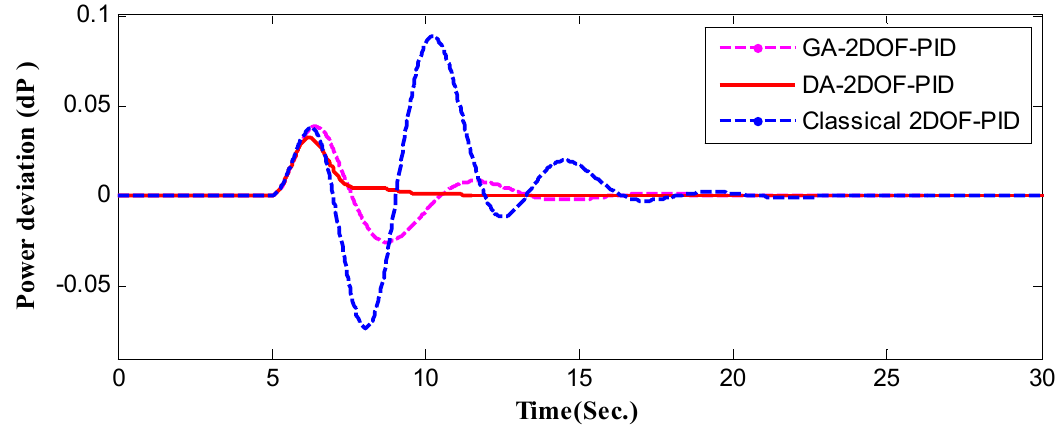
Figure 22. Δf (cid:2870) , using GA-2DOF-PID, DA-2DOF-PID, and classical-2DOF-PID with ITAE.